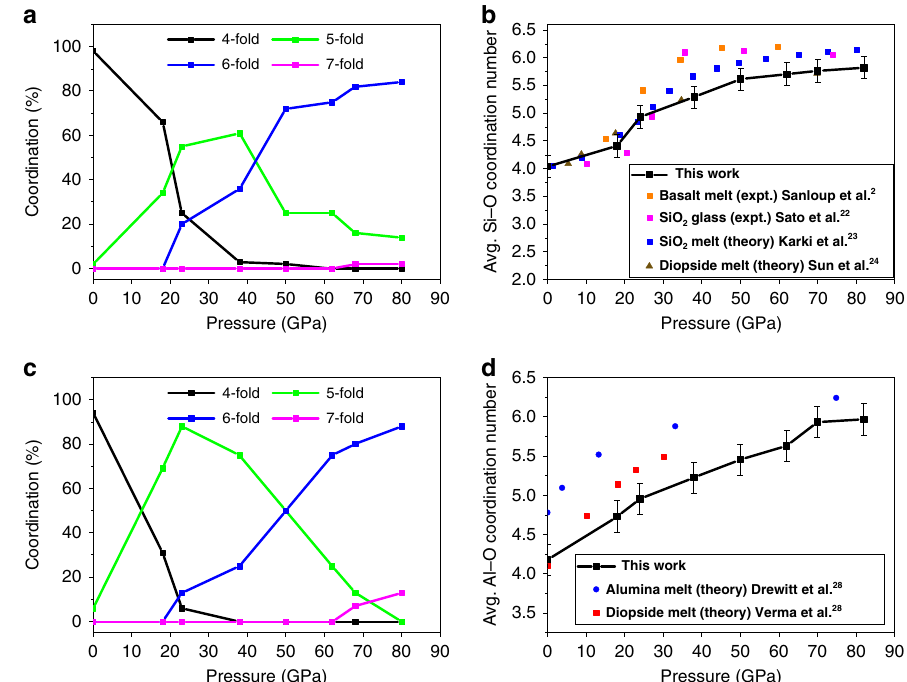
Fig. 1 Coordination numbers of Si and Al as functions of pressure. a Coordination percentage vs pressure of Si atoms with respect to O atoms at 2200 K, b average Si – O coordination number vs pressure and compared with related silicate glasses. c Coordination percentage vs pressure of Al atoms with respect to O atoms at 2200 K and d average coordination number of Al atoms vs pressure. The error bars represent the uncertainty of the calculated mean coordination numbers, which arise from uncertainties in determining the radial cut-off from the radial distribution